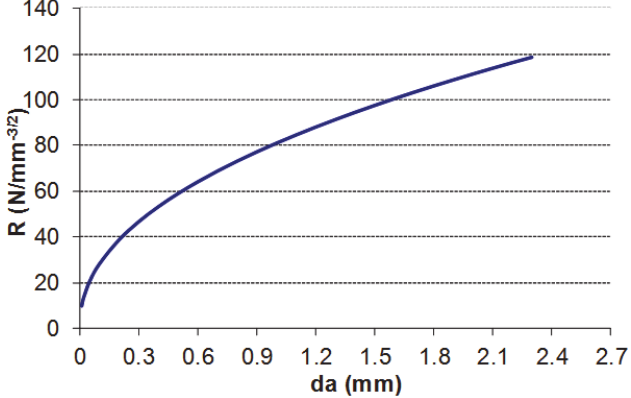
Figure 9: Al2024-T3